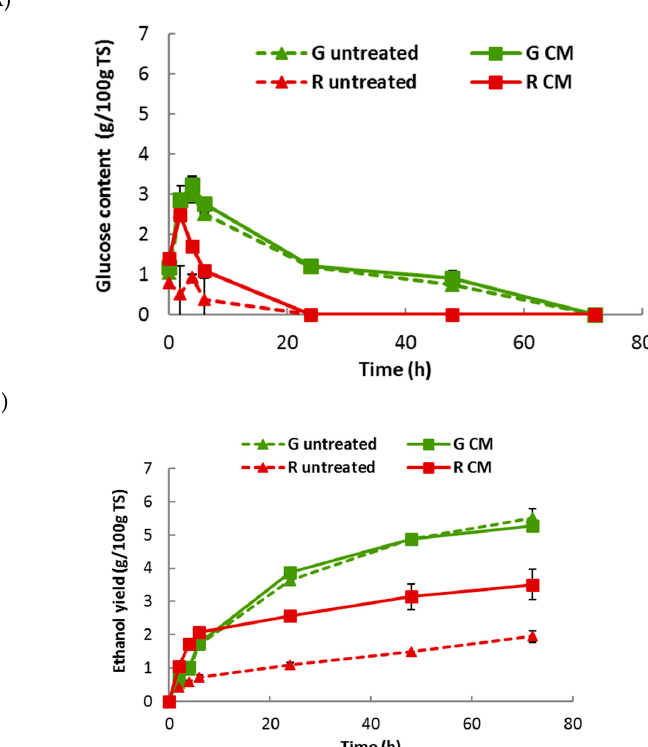
Figure 5. Simultaneous saccharification and fermentation of untreated and milled macroalgae (G: Green, R: Red) at an enzyme dosage of 10 g/L. ( A ) Glucose content (g/100 g TS); ( B ) Ethanol yield (g/100 g TS). Values correspond to mean ± SD of measurement performed in duplicate.